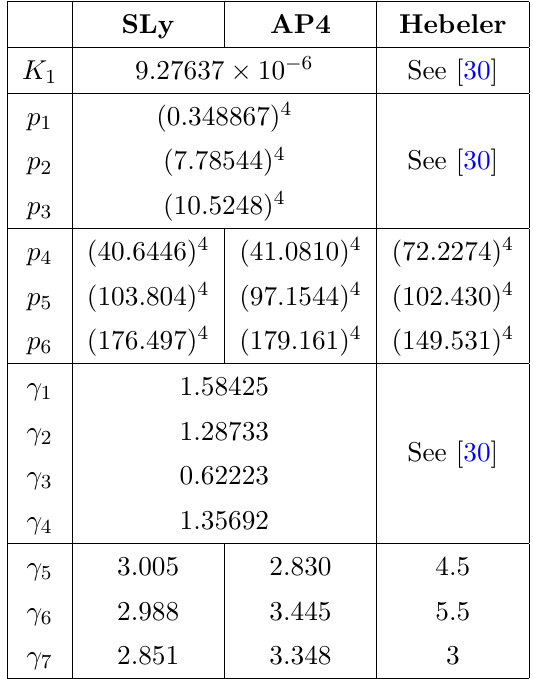
Table 1. The parameters used for each EoS. The exponents (cid:13) i are dimensionless, the various pres- sures have units of MeV 4 , and K 1 is in units of MeV 4 (cid:0) 4 (cid:13) 1 . The Hebeler et al. parametrization [30] uses a semi-analytic expression which is not piecewise polytropic in the outer region of the star, and thus cannot be displayed in the